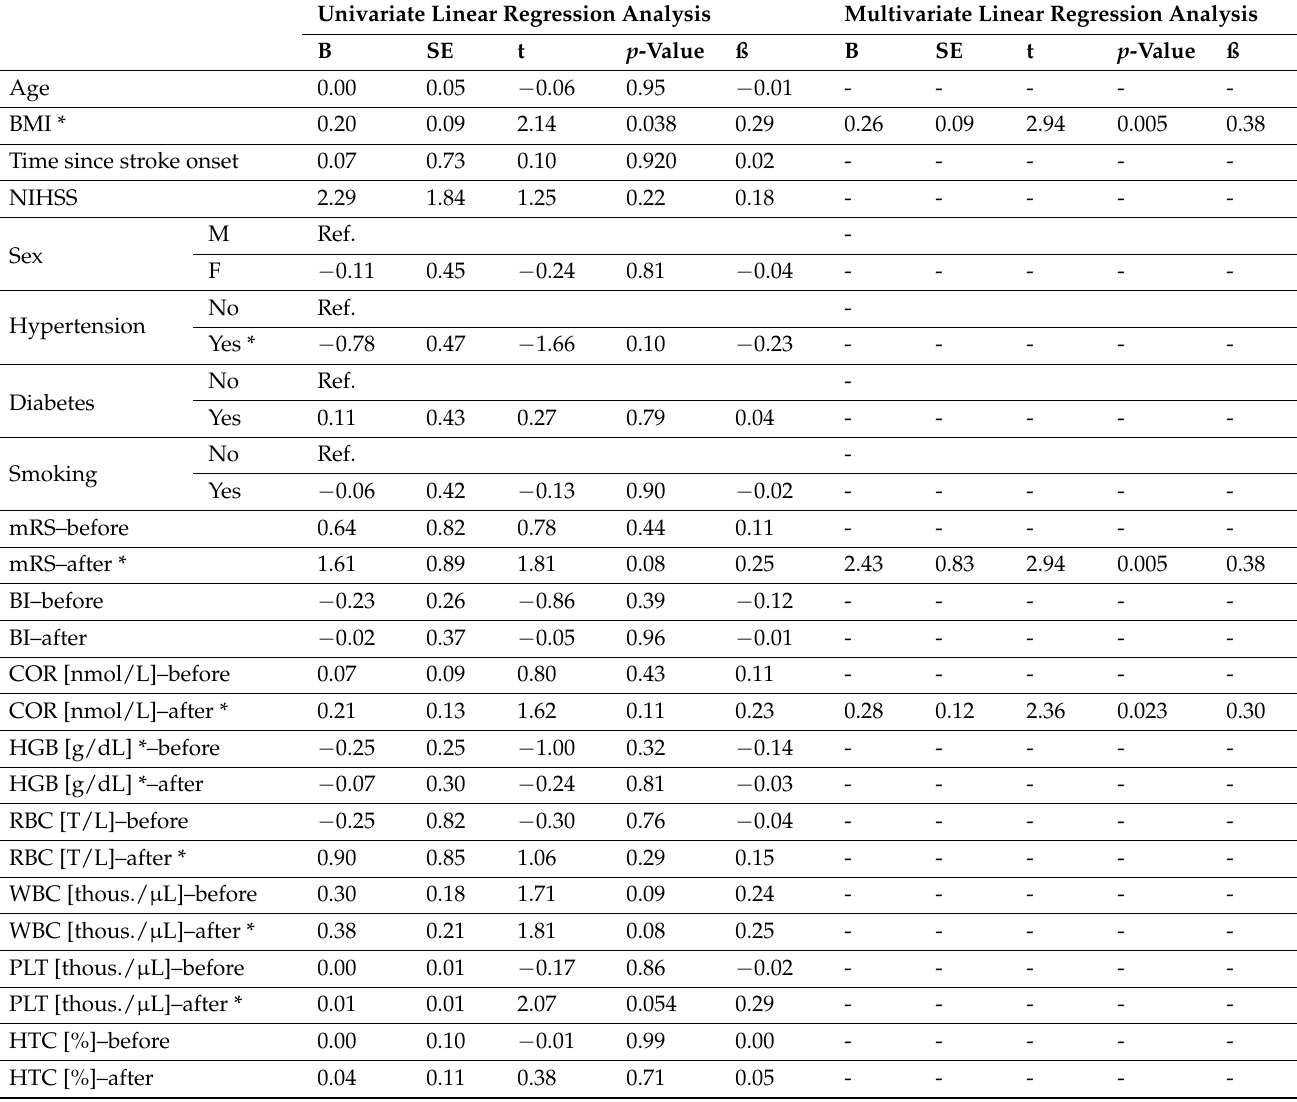
Table 5. Linear regression analyses assessing the effect of selected variables on CRP score. Univariate Linear Regression